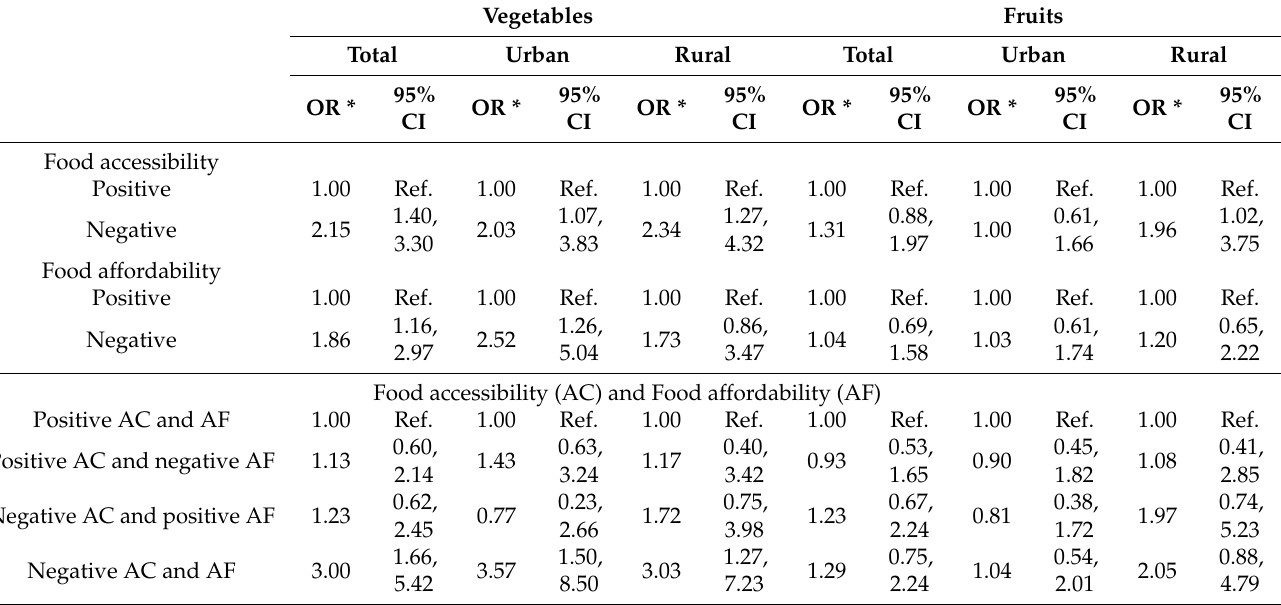
Table 5. The effect of perceived food environment on low vegetable and fruit acquisition by region. Vegetables